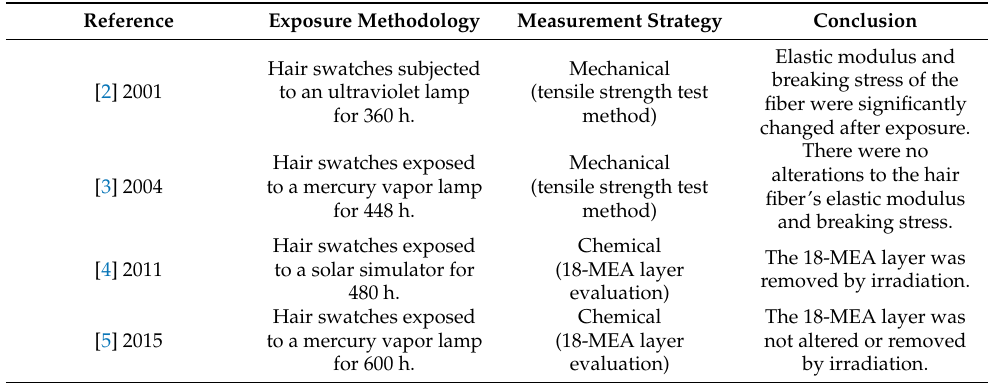
Table 1. Some examples of studies whose authors’ conclusions vary, depending on the methodology employed to expose the hair fiber to radiation and measure its resulting